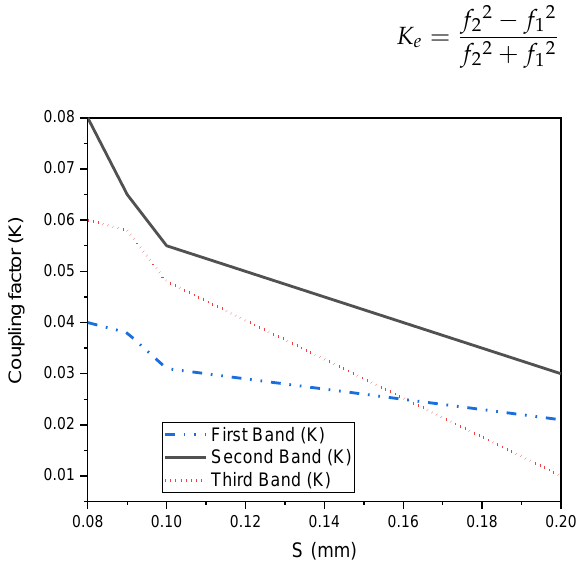
Table 5. Simulated result of “K” for different values of S.